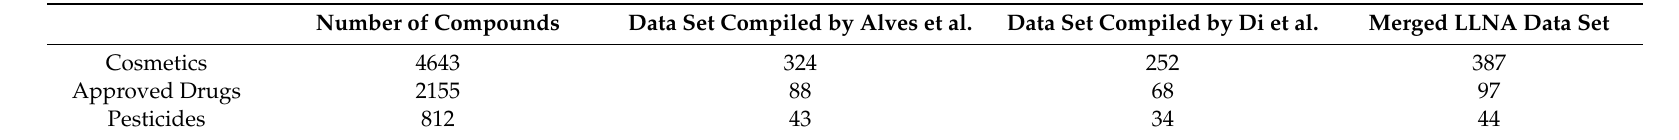
Table 2. Overlaps between the compounds contained in the LLNA data sets and the cosmetics, approved drugs and pesticides data